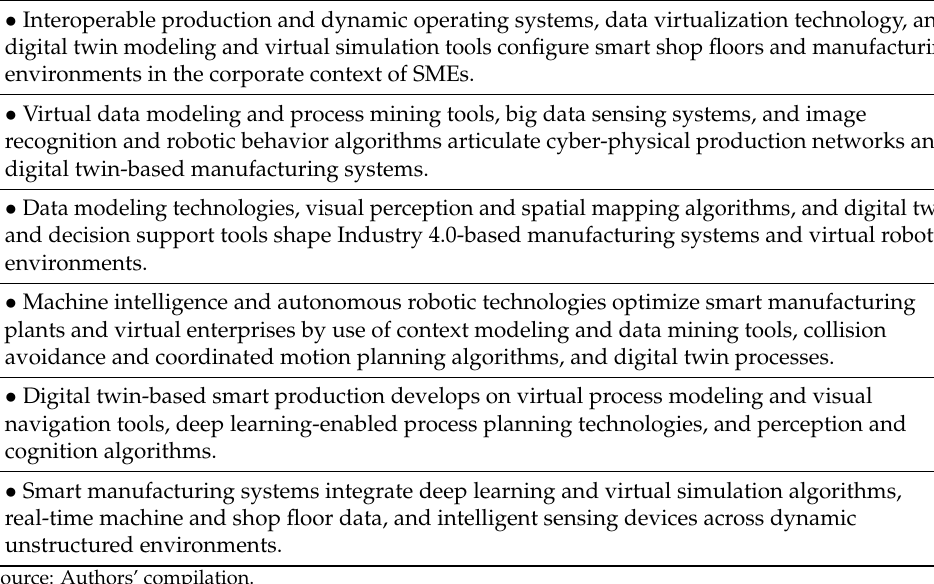
Table 6. Main research